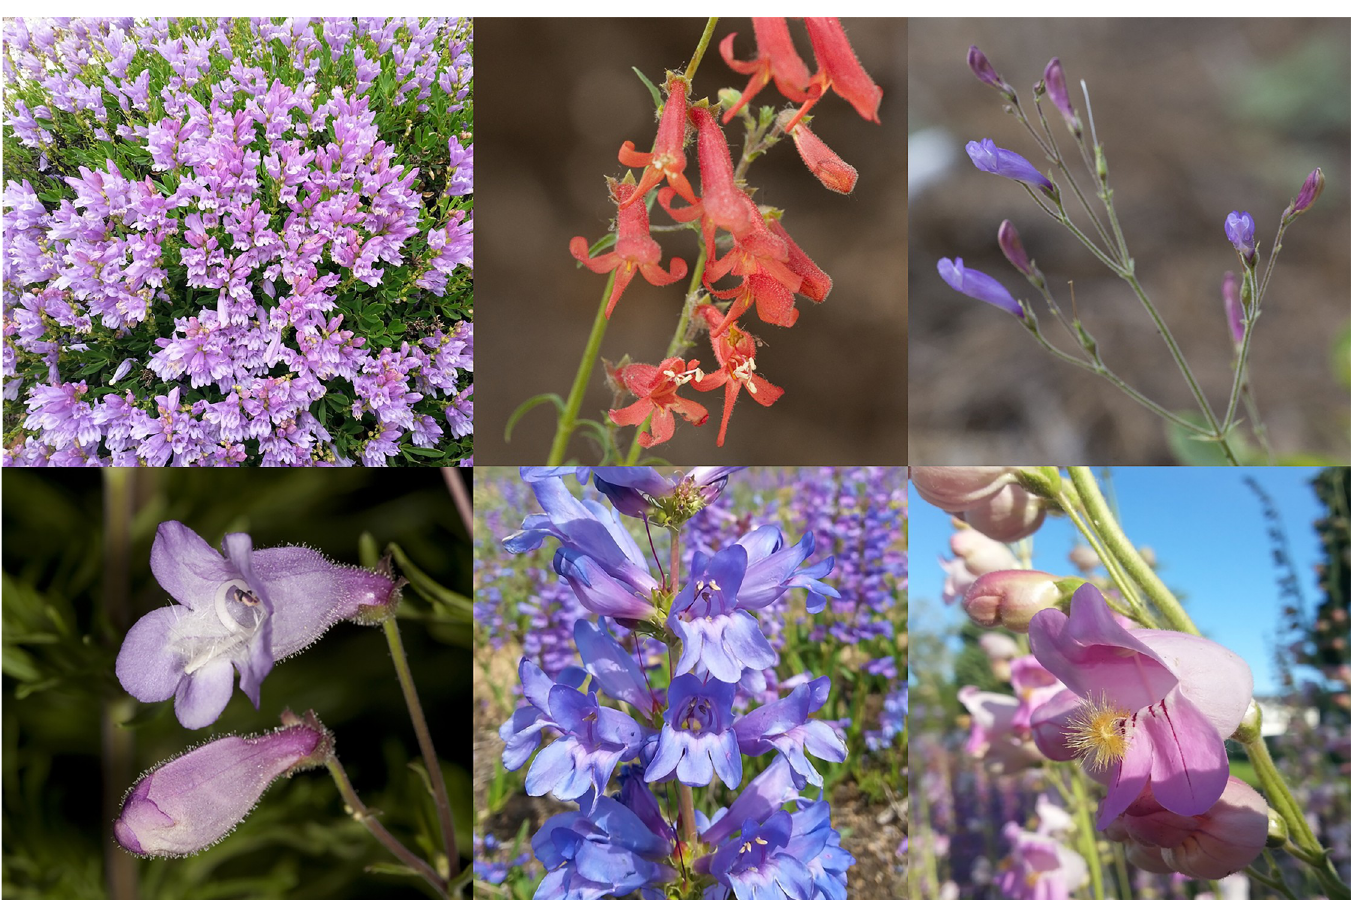
Fig 1. Photos of each species and respective subgenus included in this study. Clockwise from the upper left: Penstemon fruticosus ( Dasanthera ), P . rostriflorus ( Saccanthera ), P . personatus ( Cryptostemon ), P . palmeri ( Penstemon ), P . cyaneus ( Habroanthus ), and P . dissectus ( Dissecti ). Photo credits: Mikel R. Stevens and Jason M.